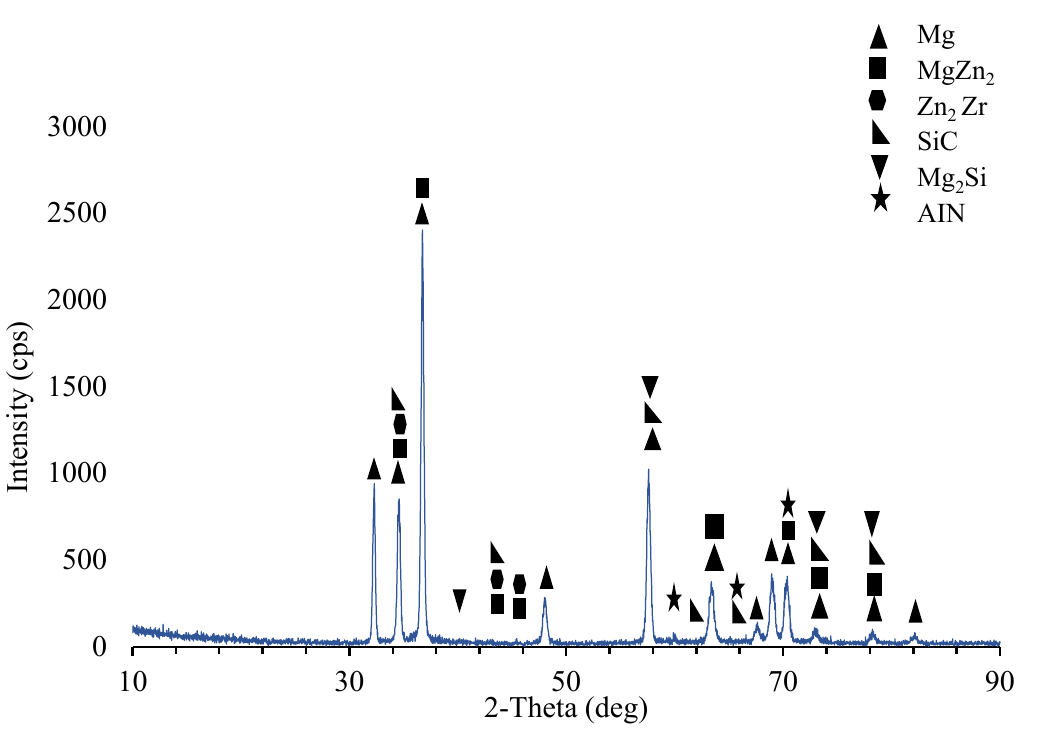
Figure 8. XRD patterns of the ZK60 SiC15 AIN0.5 composite.